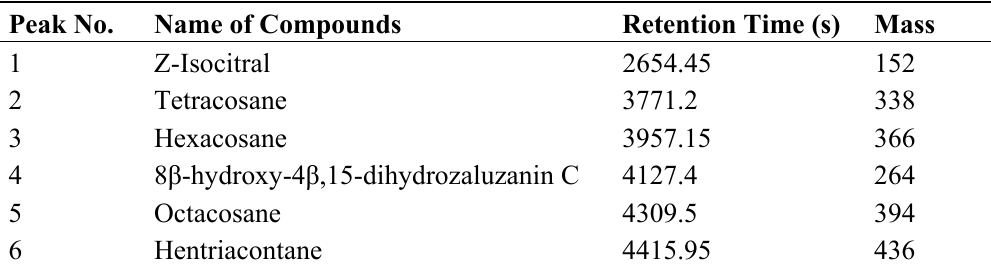
Table 2. GC-MS-TOF analysis of the hexane